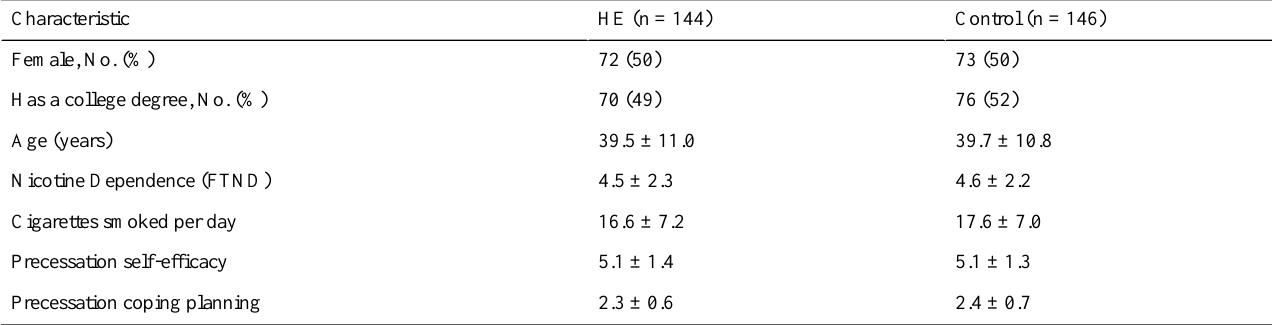
Table 2. Baseline sample characteristics a